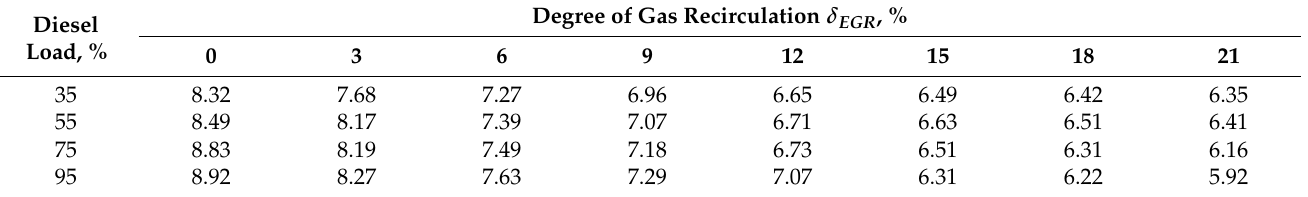
Table 1. Emission NO X , g/(kWh) marine diesel 16V32 STX-MAN under various loads and degrees recirculation δ EGR